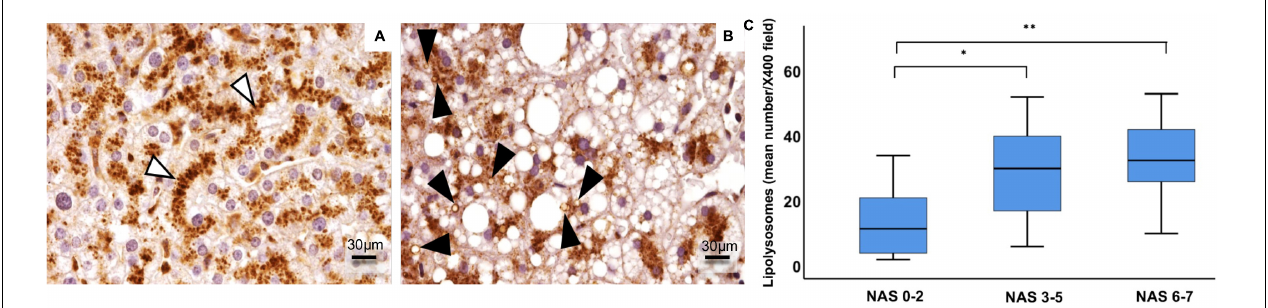
FIGURE 3 | Immunohistochemical expression of LAMP1 in human hepatocyte lysosomes (LAMP1-positive particles) were regularly disposed along the path of biliary canaliculi in healthy liver (A) , while they were patchy distributed in fatty liver (B) . In fatty liver of NAFLD patients ( n = 59), enlarged fat-loaded lysosomes, namely lipolysosomes, could be individuated as intracellular droplets with lysosomal LAMP1-positive membrane and visible lumen ( B , arrowheads). The number of lipolysosomes/field at light microscopy increased in NAFLD patients with higher NAS (Non-alcoholic fatty liver disease Activity Score) (C) . Original